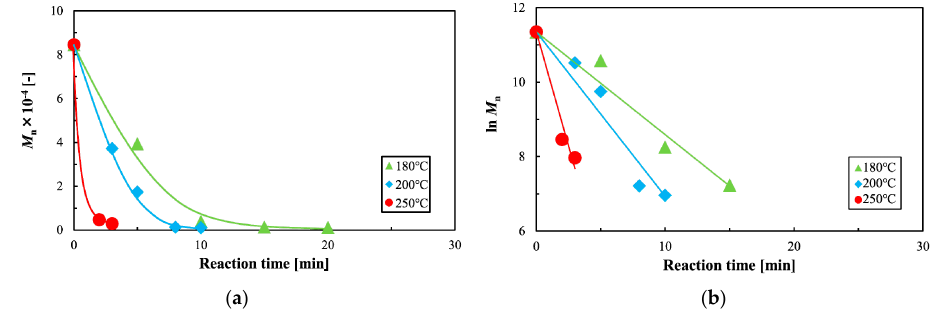
Figure 2. Kinetic analysis of polylactic acid (PLA) degradation. ( a ) Number average molecular weight ( M n ) of PLA after treatment with sub-critical water, according to reaction time and temperature and ( b ) analysis of the reduction in molecular weight due to sub-critical water, using a first-order equation. Table 2. Kinetic constant of decreasing number average molecular weight ( M n ).